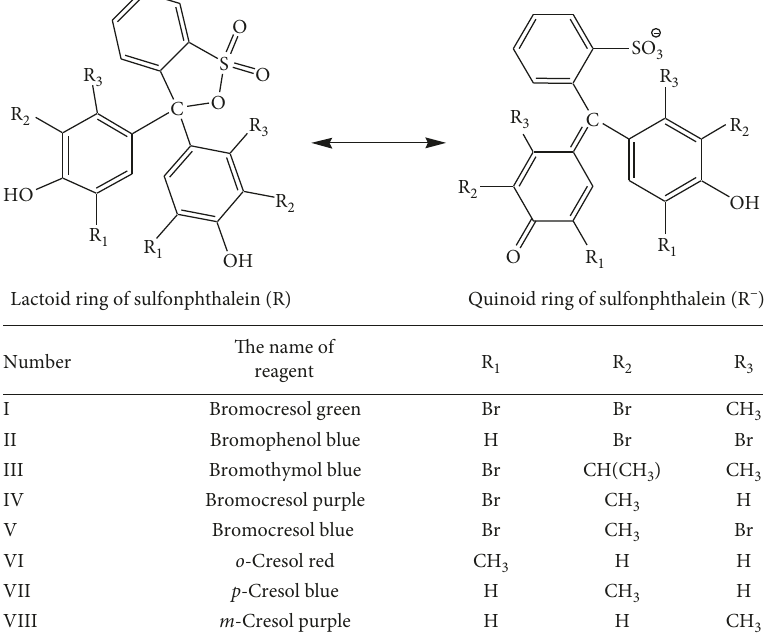
Scheme 1: The different forms of sulfonphthalein dyes.